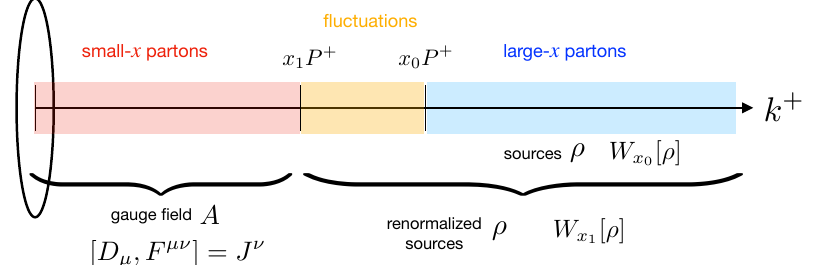
Figure 10. Schematic representation of the quantum evolution of the weight-functional. Quantum fluctuations in the interval [ x 1 , x 0 ] (shown in yellow) are absorbed into stochastic fluctuations of the color sources by redefinition of the weight functional W x choice of the scale separating small- x and large- x partons is thus arbitrary and different choices are related by the JIMWLK renormalization group equations. The long right bracket represents how large- x partons and fluctuations are considered as sources after properly evolving of weight functional.